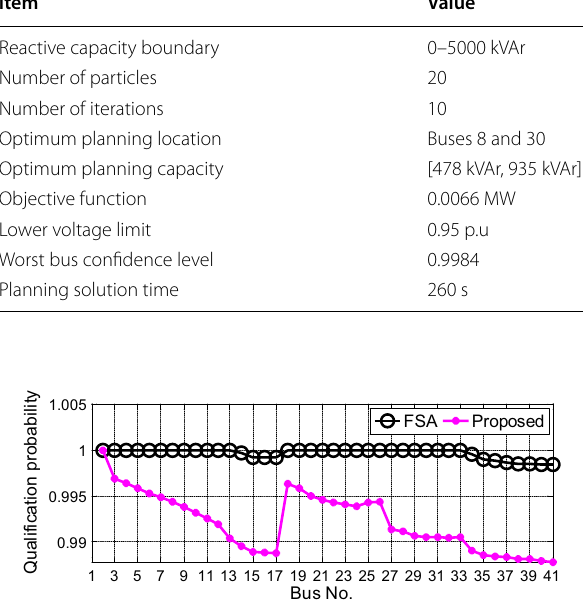
Fig. 14 Bus voltage qualification probabilities